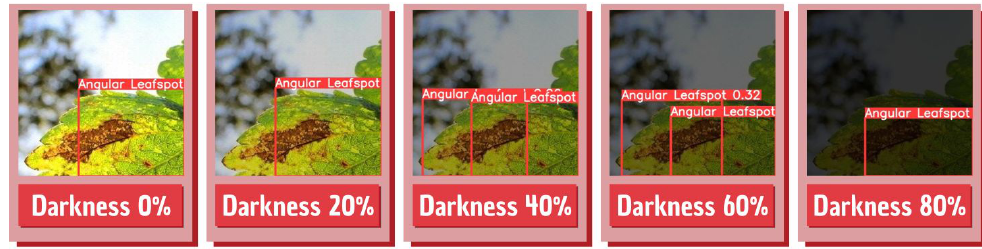
Figure 26. Successful detections performed in different brightness profiles.